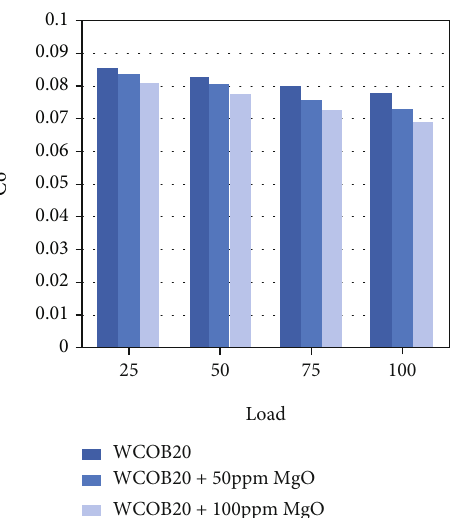
Figure 9: Load vs. brake thermal e ffi ciency.